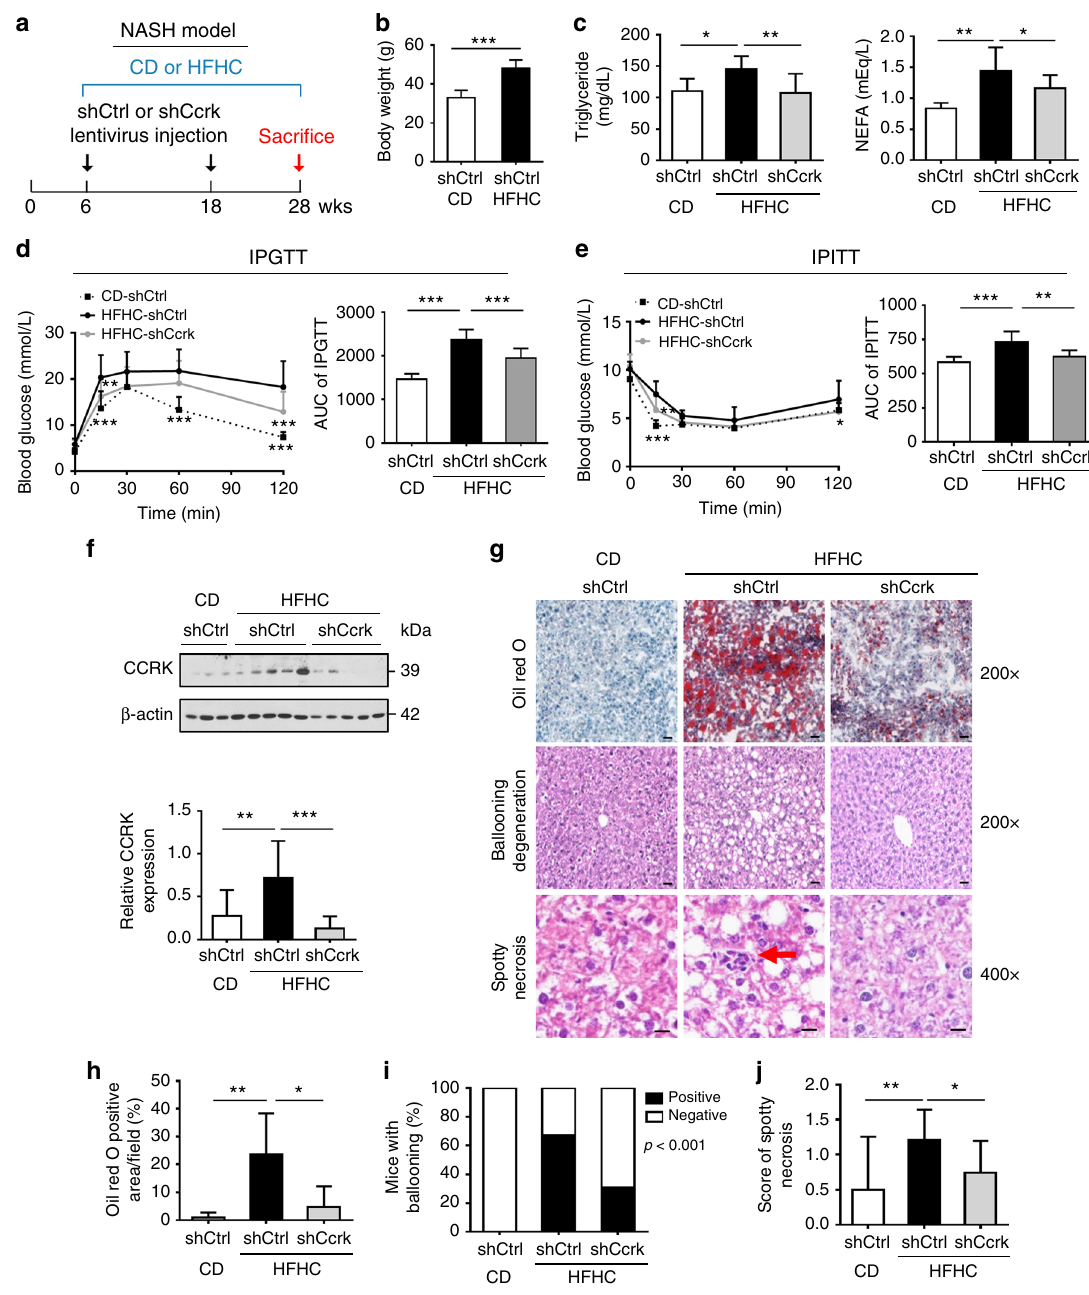
Fig. 1 Dietary obesity-induced CCRK over-expression promotes lipid accumulation, glucose intolerance, and liver damages in male mice. a Schematic diagram of NASH mouse model with different diets (CD chow diet, HFHC high-fat high-carbohydrate) and lentivirus-mediated Ccrk knockdown (CD + shCtrl, n = 8; HFHC + shCtrl, n = 15; HFHC + shCcrk, n = 15). b Body weight, c blood triglyceride and non-esteri fi ed fatty acid (NEFA) levels in mice were increased by HFHC at 28 weeks, which could be reduced by Ccrk knockdown. d , e CCRK impaired insulin sensitivity in mice. d Intraperitoneal glucose tolerance test (IPGTT) and e intraperitoneal insulin tolerance test (IPITT) were performed on CD-fed and HFHC-fed mice, blood glucose was measured at indicated time points after glucose or insulin injection (left), and area under the curve (AUC) is shown in a bar chart (right). f CCRK protein expression was induced by HFHC in mouse livers, which could be reduced by shRNA-mediated knockdown. Quanti fi cation of CCRK protein levels (relative to β -actin) is shown in a bar chart (bottom). g Representative pictures of Oil Red O, ballooning degeneration, and spotty necrosis of liver tissues in different groups (image magni fi cation = ×200 or ×400, scale bar = 20 μ m). h , i Quanti fi cations of Oil Red O, ballooning degeneration and j scoring of spotty necrosis showed increased lipid accumulation, ballooning and spotty necrosis in HFHC-fed mice, which were reduced by Ccrk knockdown. Data are presented as mean ± SD. * p < 0.05; ** p < 0.01; and *** p < 0.001 as calculated by unpaired two-tailed Student ’ s t -test ( b ), one-way ANOVA followed by Bonferroni post-hoc test ( c – f , h , j ), two-way ANOVA followed by Bonferroni post-hoc tests ( d , e ), and Chi-square test ( i